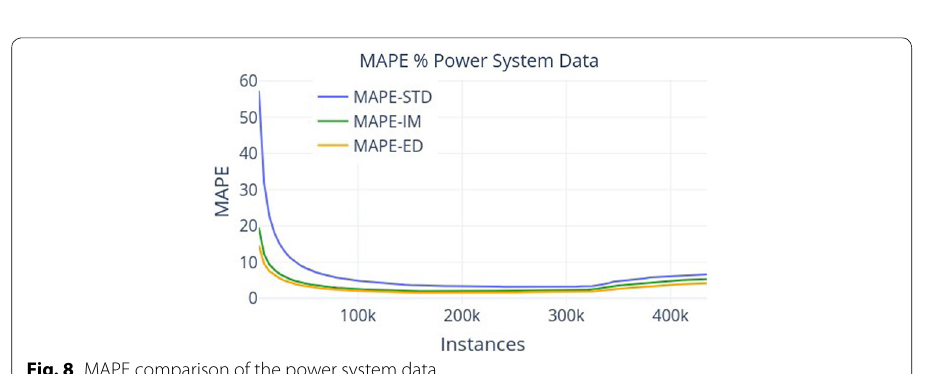
Fig. 8 MAPE comparison of the power system data